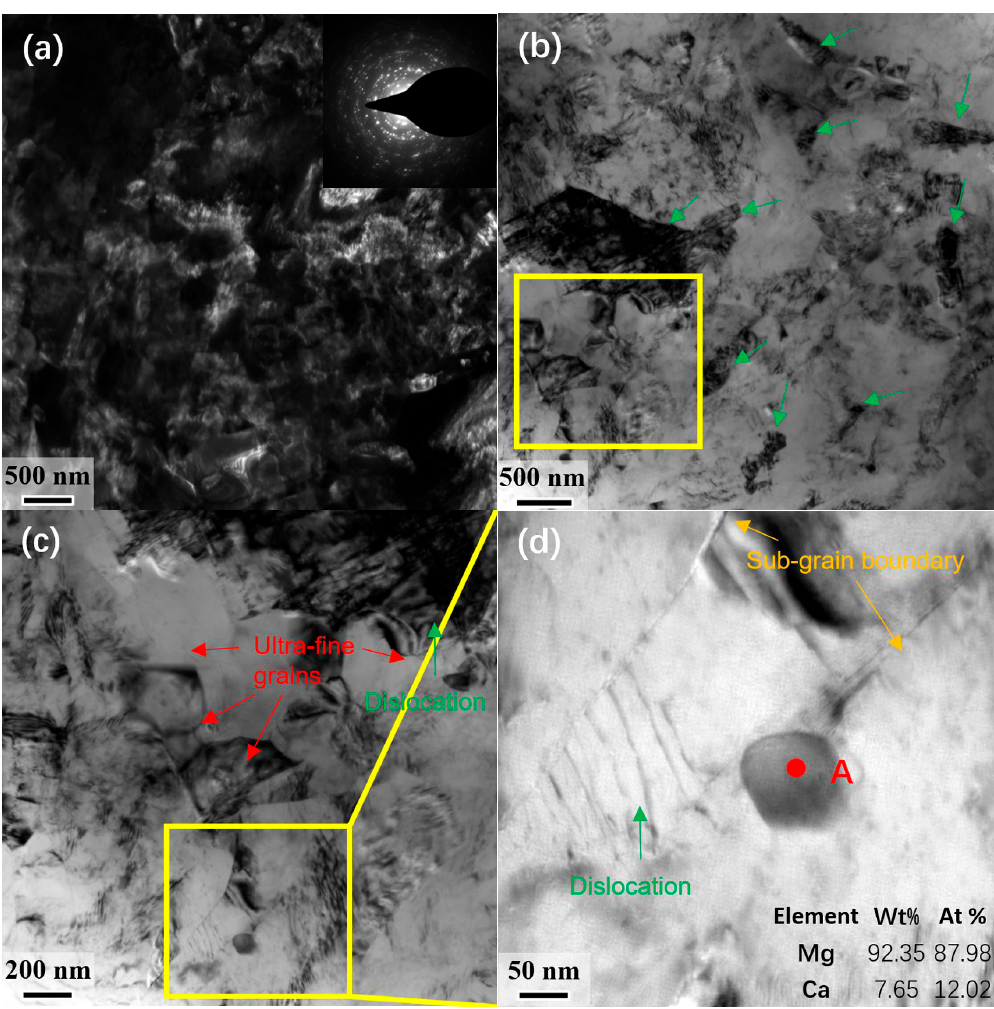
Figure 6. ( a ) Dark field TEM image and corresponding selected area electron diffraction (SAED) pattern of the E-CRed sample, and ( b–d ) bright field images and energy-dispersive X-ray spectroscopy (EDX) results of the precipitate.